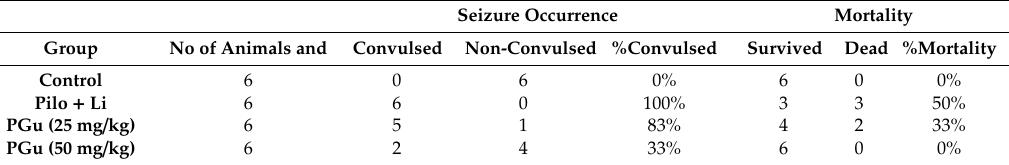
Table 1. Contingency table showing the e ff ect of PGu on the occurrence of seizures and mortality rates.